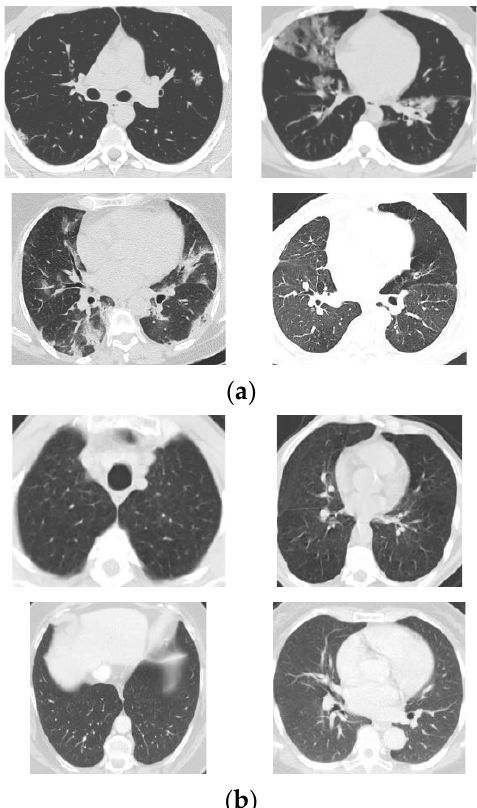
Figure 1. Random CT scans in the SARS-CoV-2 dataset (( a ) COVID-19 samples, ( b ) Non-COVID-19 samples).